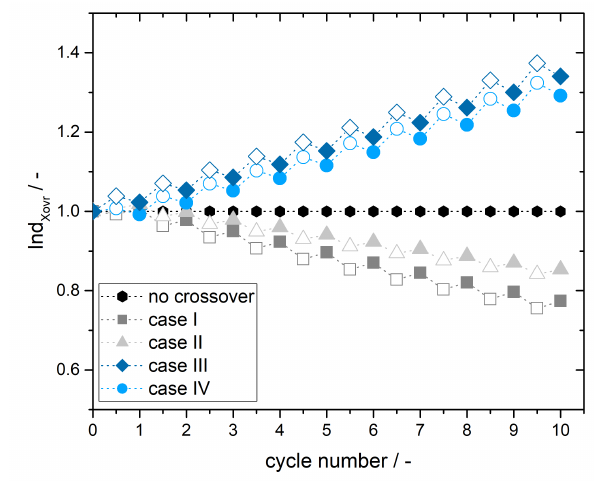
Figure 4. Simulated crossover index Ind Xovr for cases I-IV. Case I and II refers to vanadium species crossing from the negative half-cell (NHC) to the positive half-cell (PHC), Case III and IV considers crossover from PHC to NHC. According to cycle numbers full numbers display a discharge half-cycle (filled icons) and half numbers (x,5) display a charge half-cycle (empty